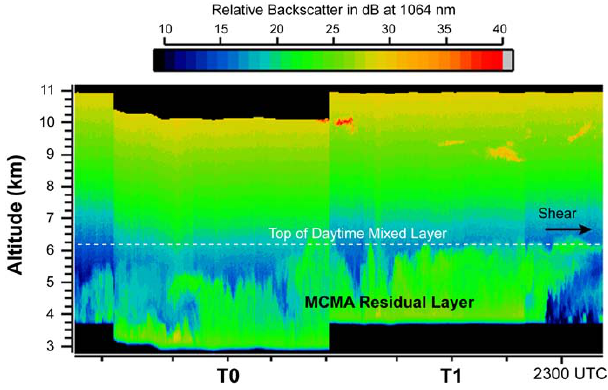
Fig. 8. Scanning Aerosol Backscatter LIDAR (SABL) infrared im- age from the C-130 showing the polluted residual layer extending above 6000m in Mexico City at approximately 23:00 UTC on 18 Figure 8. Scanning Aerosol Backscatter LIDAR (SABL) infrared image from the C-130 3 March. The eastward shear at 5–6km is consistent with the west- erly winds aloft that were measured at the same time by first CMET showing the polluted residual layer extending above 6000 m in Mexico City at approximately 4 balloon sounding. Note that left and right both are to the east in this 23:00 UTC on 18 March. The eastward shear at 5-6 km is consistent with the westerly winds 5 partially mirrored image because the C-130 was flying northwest aloft that were measured at the same time by first CMET balloon sounding. Note that left and 6 over T0 and the east over T1 (see Fig. 7b). The LIDAR was looking upwards and the C-130 was flying between 3–4kmm.s.l. Discon- right both are to the east in this partially mirrored image because the C-130 was flying 7 tinuities, such as the step between T0 and T1, are due to turns and northwest over T0 and the east over T1 (see Fig. 7). The LIDAR was looking upwards and 8 rapid changes in altitude compounded here by the approximate na- ture of this assembled the C-130 was flying between 3-4 km MSL. Discontinuities, such as the step between T0 and 9 T1, are due to turns and rapid changes in altitude compounded here by the approximate nature 10 of this assembled image. 11